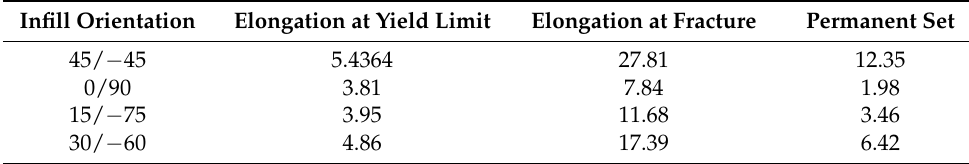
Table 4. Elongation values for the selected infill orientations